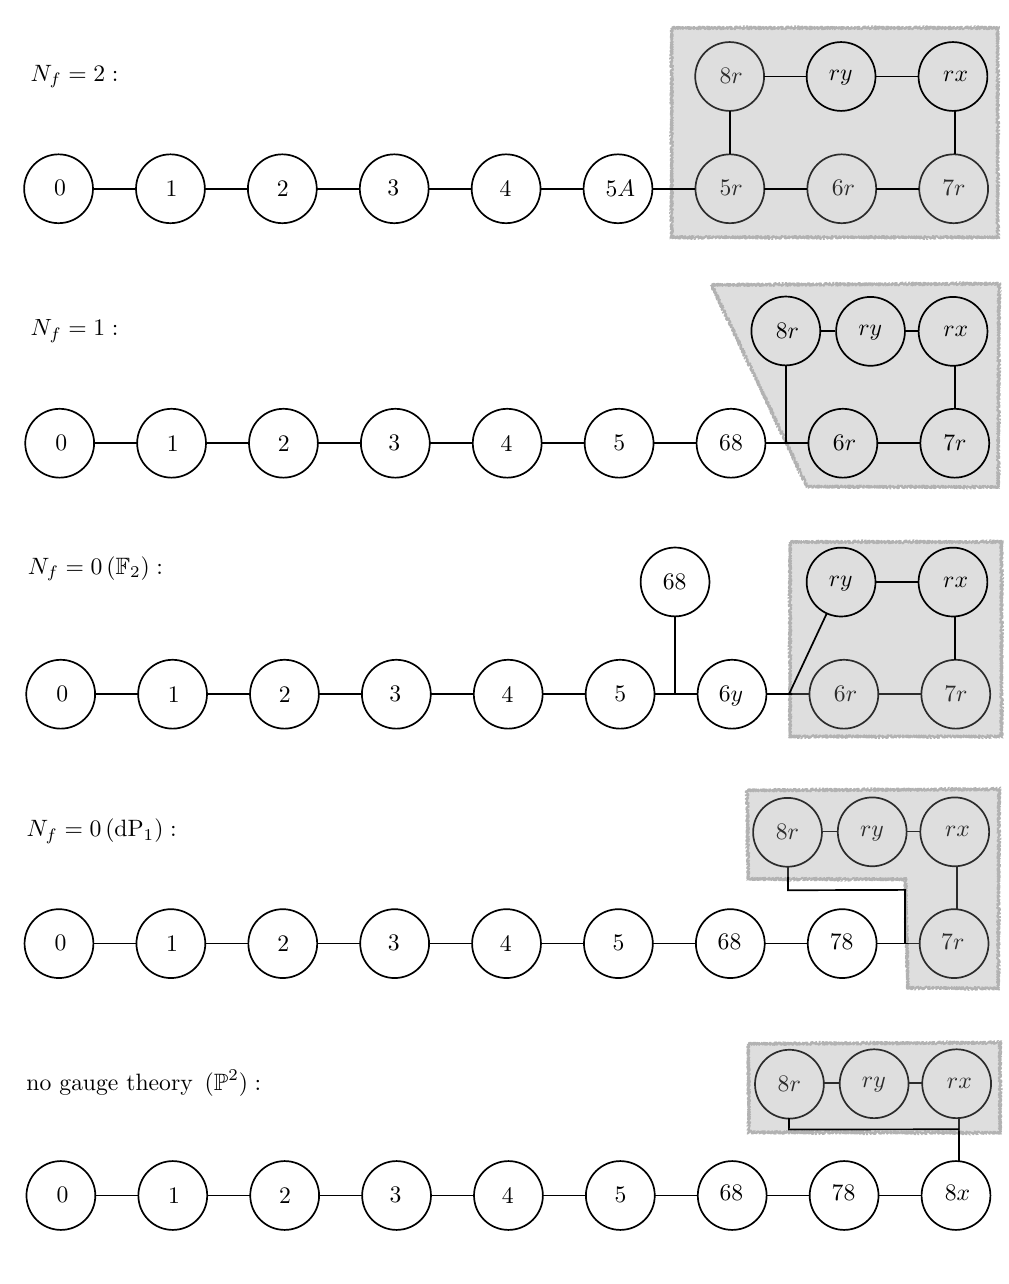
Figure 10 . The resolved non-(cid:13)at (cid:12)bers realizing the rank one theories. The P 1 s (represented by circles) carrying a single number n inside are the non-splitting (cid:12)bers of the exceptional E 8 divisors A n . Labels q 1 q 2 indicate a curve de(cid:12)ned by f q 1 g \ f q 2 g , where q 1 (cid:24) = n stands for (cid:11) n . The only exception is the curve 5 A , which is the vanishing of (cid:11) 5 and a two-term polynomial (see equation (5.4)). Lines indicate pairwise intersections; ? signals that three P 1 s intersect at one point. The gray box with enclosed circles represents the non-(cid:13)at surface with curves contained inside of it.